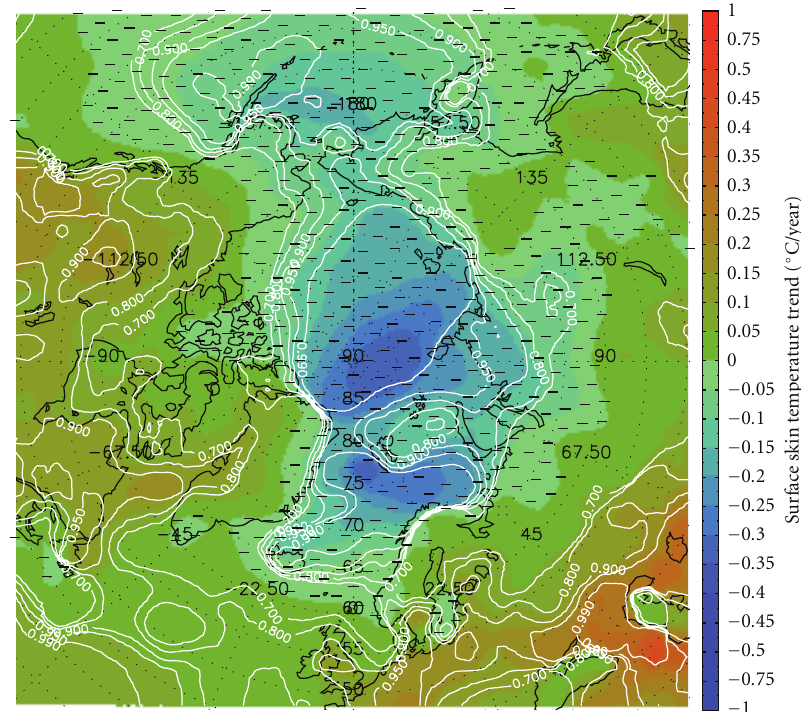
Figure 4: Surface skin temperature trend image for the Arctic in winter over the period of 1982 to 2004. The contours in the image indicate the confidence levels, and color represents the surface temperature trend in degrees per year. Areas with cooling trends are marked with